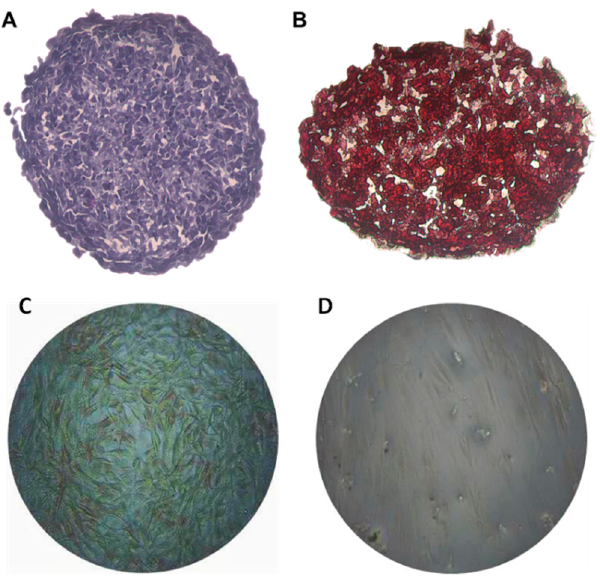
Figure 2. Histological sections of aggregates of 20,000 cells with 4 days of formation. ( A ) Sections stained with H&E. ( B ) Sections stained with alizarin red. ( C ) MG63 osteoblasts cultured in monolaminar 2D cell culture at day four, stained with alizarin red in the same culture conditions of the osteospheres, where the absence of significant staining can be observed. ( D ) Human gingival fibroblasts in monolaminar 2D cell culture, presented as a negative control for mineralization after staining with alizarin red.